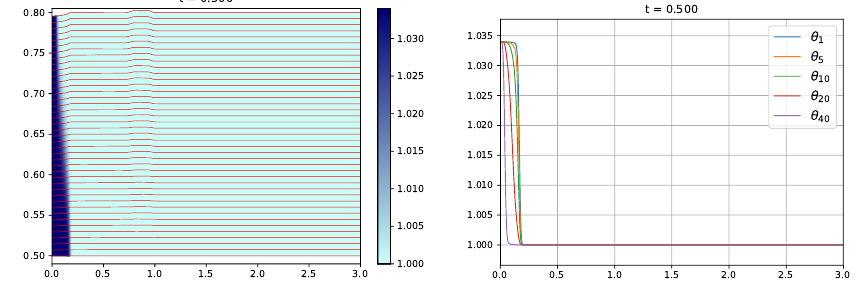
Figure 19. Evolution of the density driven current at t = 0.5 s.